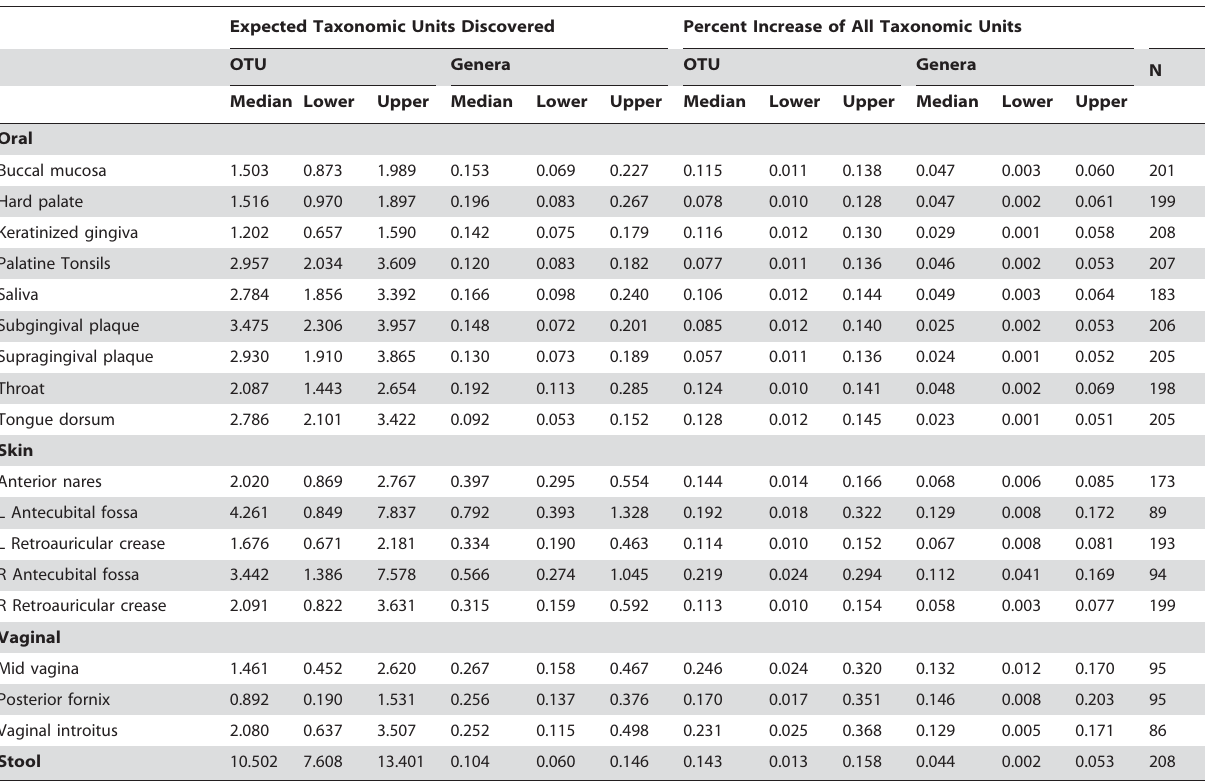
Table 3. Expected taxonomic discover rates upon additional sampling, estimated with bootstrapping and curve